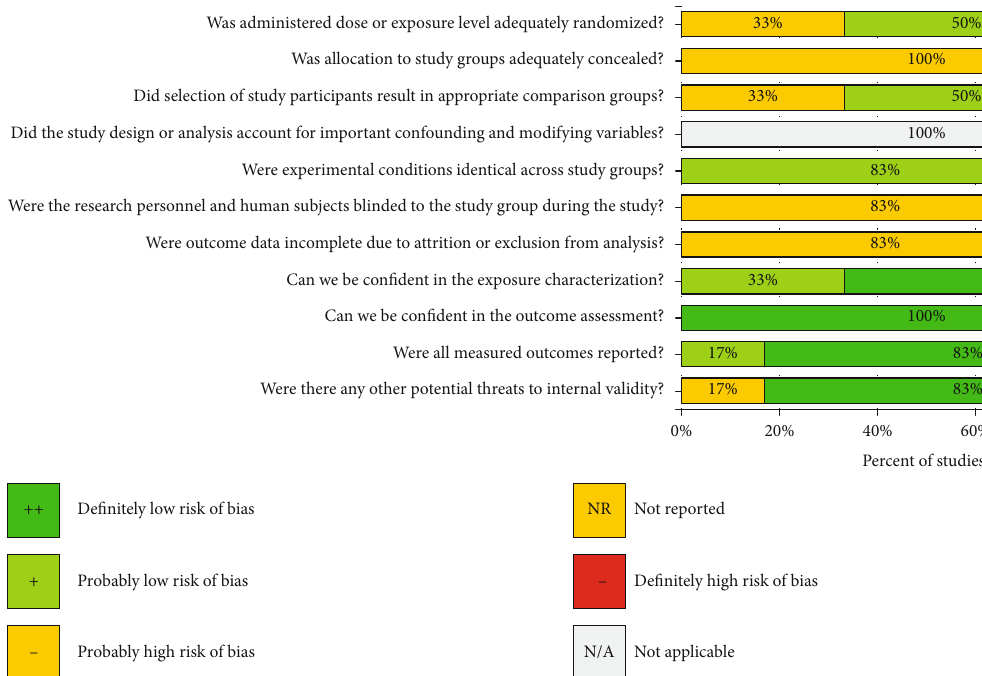
Figure 3: A study evaluation bar chart showing the percent of studies with each score, for each metric, in animal